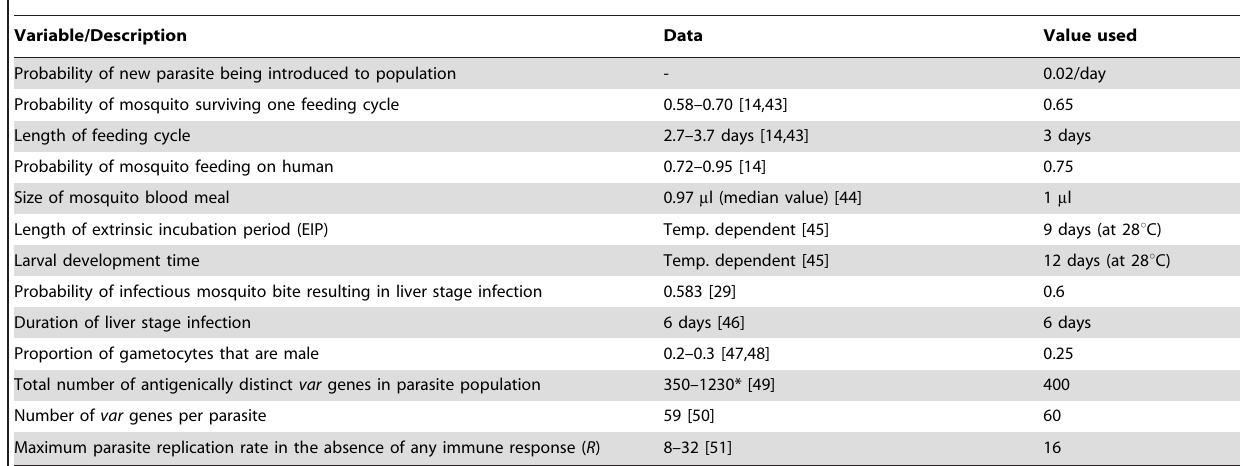
Table 1. Description of variables used in the